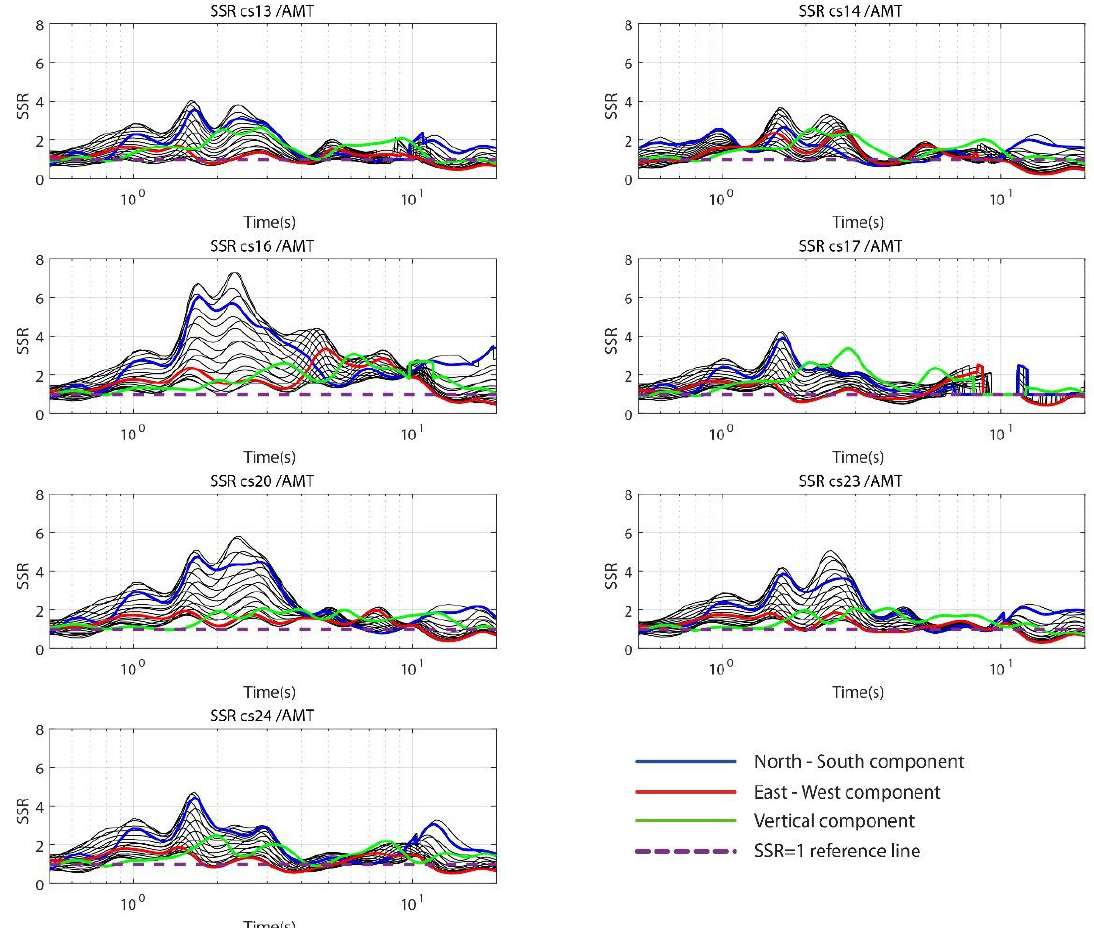
Figure 4. Standard spectral ratio (SSR) of the CS stations with respect to AMT between 0.5 to 20 Hz (for CS13 to CS24). Black lines represent the 18 (1) horizontal (vertical) components, blue (red) lines represent the north – south (east – west) components, green lines represent the vertical components; purple dotted lines represent the reference level of SSR = 1.